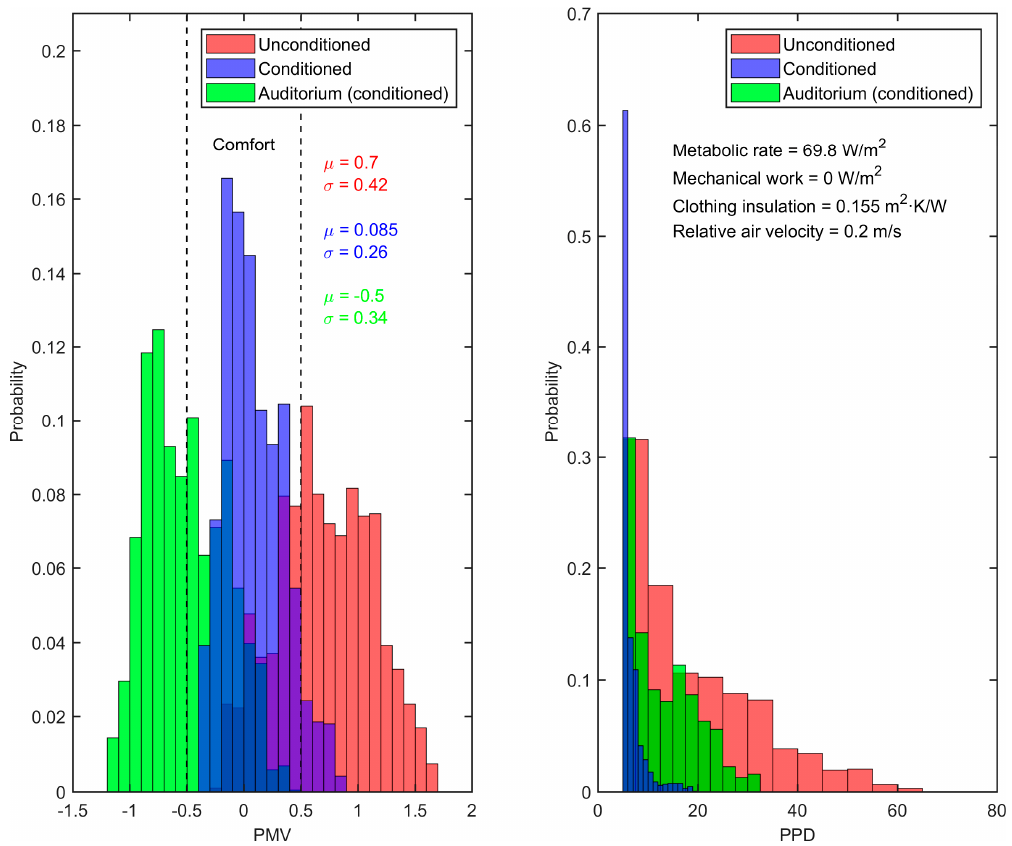
Figure 8. ( a ) Predicted Mean Vote (PMV) including mean (µ) and standard deviations ( σ ) and ( b ) Percentage of People Dissatisfied (PPD) for the auditorium and the unconditioned (reference) and conditioned rooms. PMV mean and standard deviations are given in the left figure.